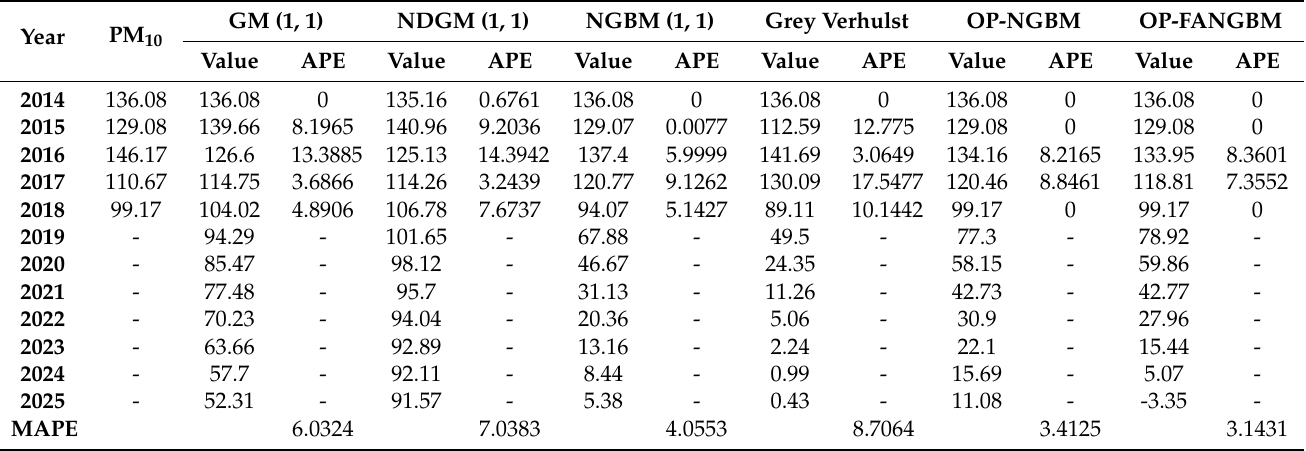
Table 3. Results of different models for PM 10